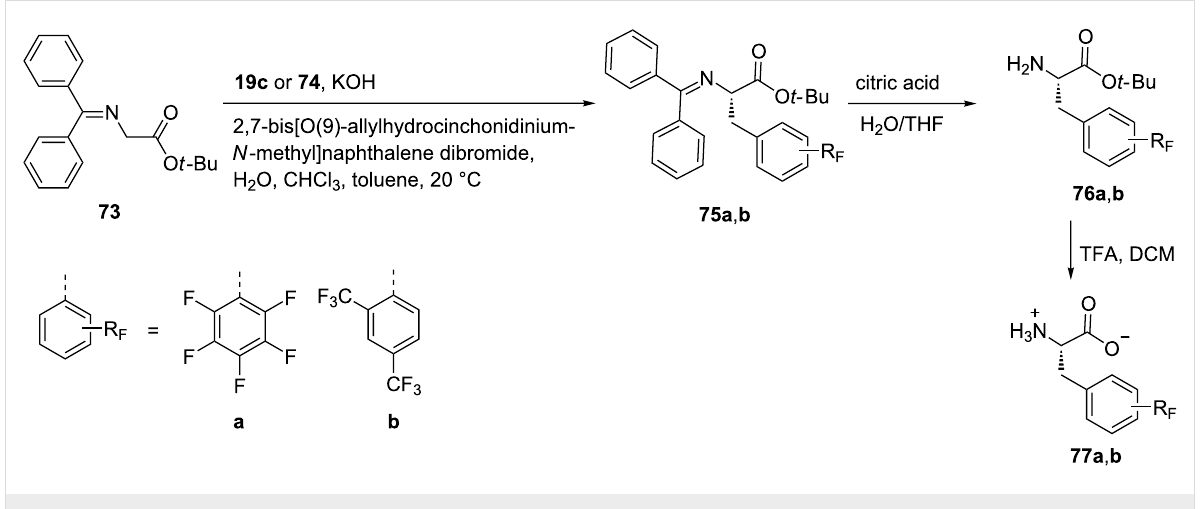
Scheme 18: Synthesis of FPhe derivatives via intermediate imine formation.